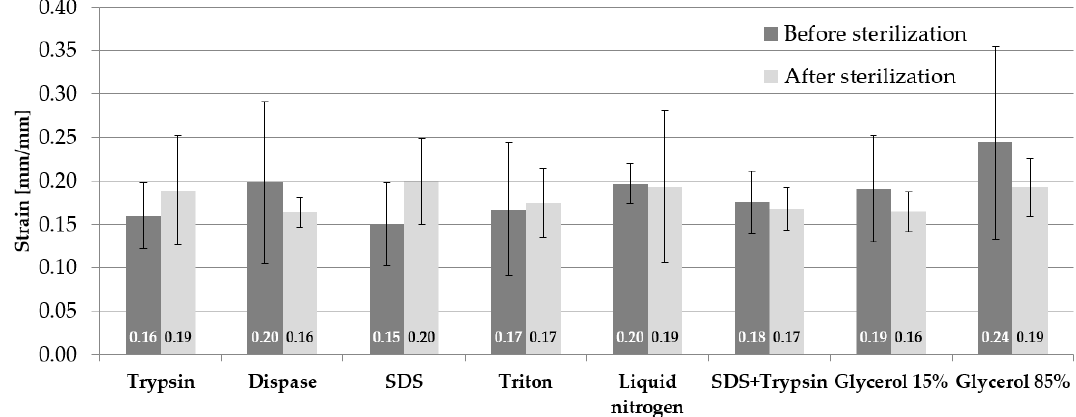
Figure 4. Mean values of maximum strain.